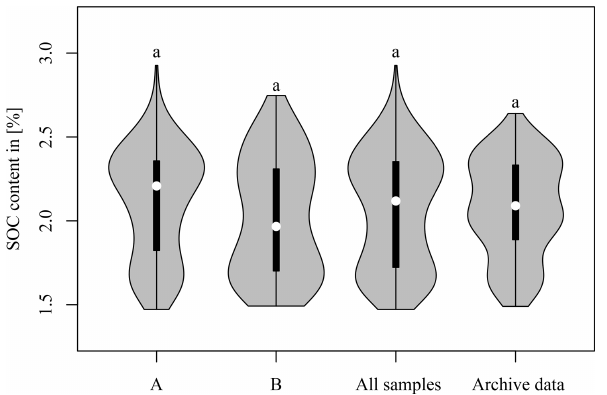
Figure 7. Soil organic carbon (SOC) content of the three soil sam- ple sets A (left), B (middle), and all (middle) and of archive data measured from 2004 to 2007 (right). The thin line shows the 95% confidence interval, the bar the interquartile range, and the dot the median. Mann–Whitney U test was used to compare A, B, and all samples to the archive data. The three soil sample sets were not compared among each